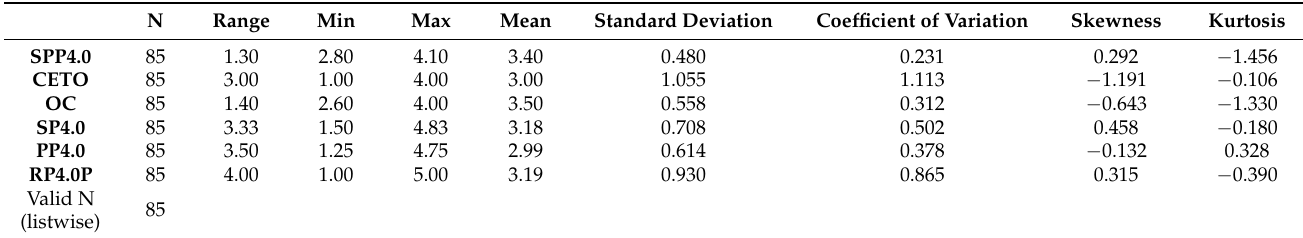
Table 1. Descriptive statistics for SPP4.0, CETO, OC, SP4.0, PP4.0, and